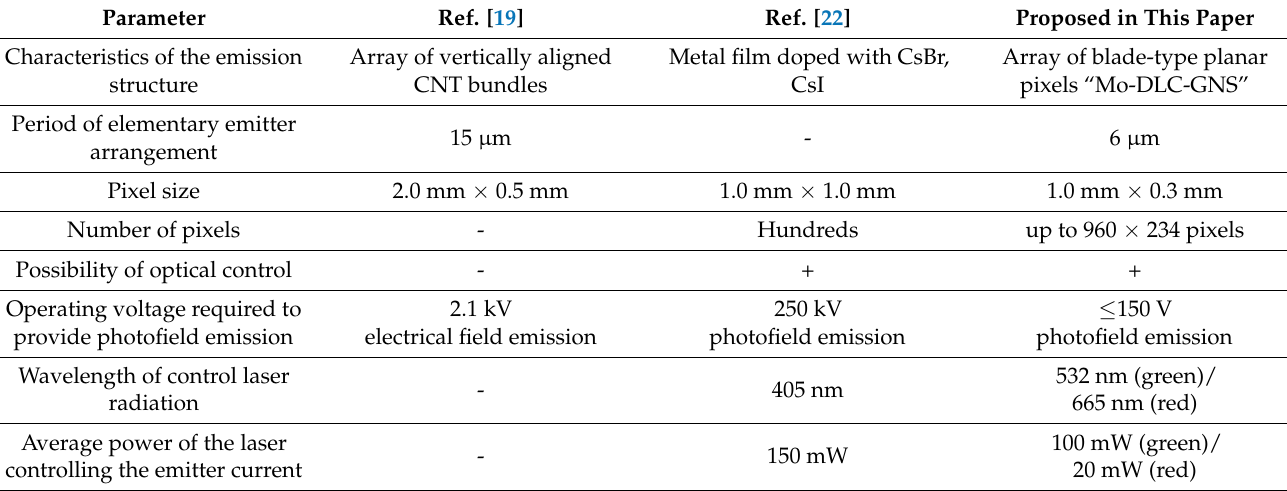
Figure 7. Dependence of the photocurrent, normalized to the value of the maximum dark current I 0 , with a change in the value 1/ U : square markers correspond to red laser irradiation ( λ = 662 nm, laser power P 662 of 20 mW, triangular markers correspond to green laser irradiation ( λ = 532 nm, laser power P 532 of 100 mW. The inset shows the absorption spectrum of GNPs in air, where the wavelengths of the used lasers are shown. Table 1. Comparison of the parameters of non-incandescent matrix sources of electron current for X-ray